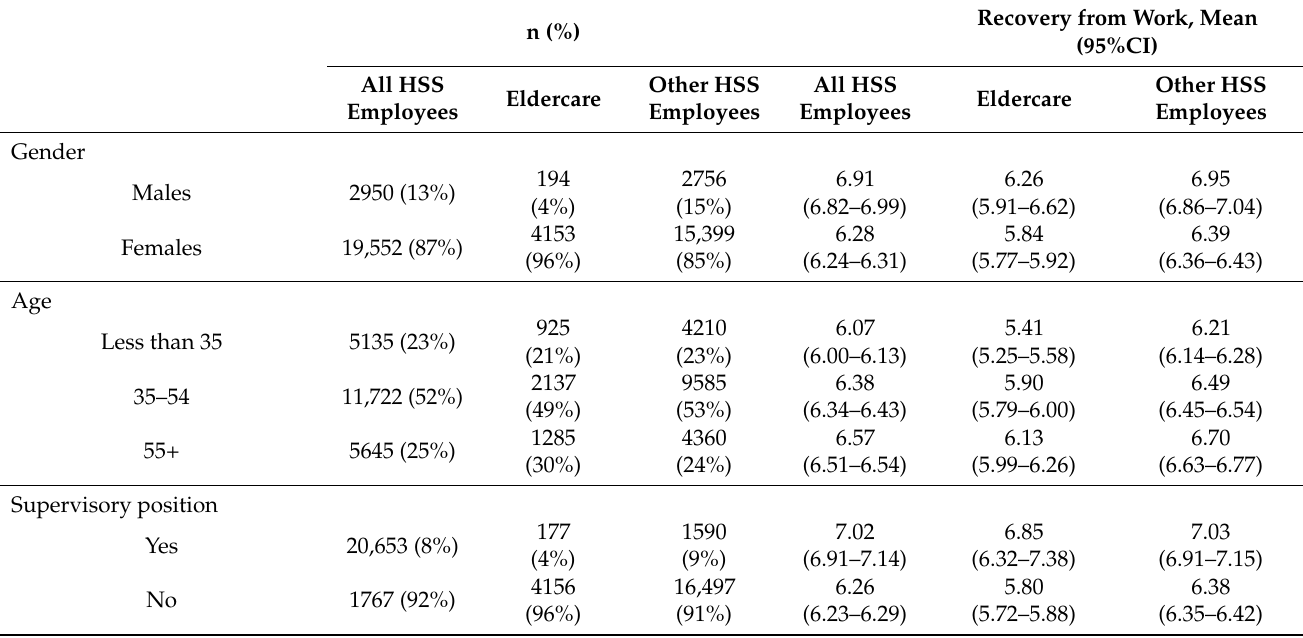
Table 1. Demographics and recovery from work in different employee groups. The table presents sample sizes, mean and 95 % confidence intervals (CI) for recovery from